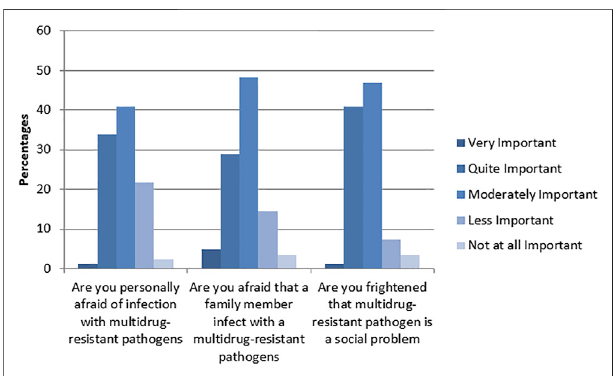
FIGURE 3 | Fears of individuals regarding MDR